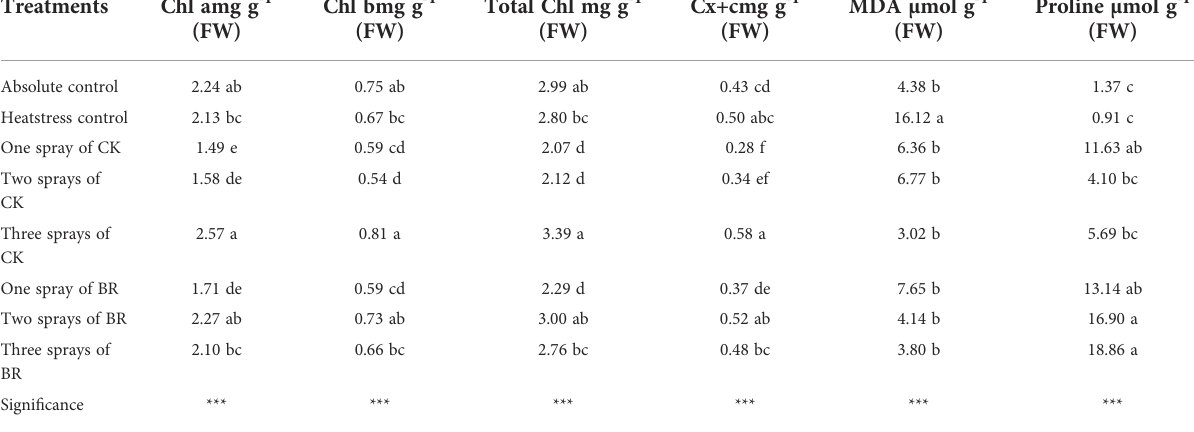
TABLE 2 Effect of the number of sprays of two growth regulators (cytokinins (CK) or brassinosteroids (BR)) on biochemical variables of rice plants of genotype Fedearroz 2000 subjected to combined heat stress (40°C day/30°C night) at 55 days after emergence (DAE).